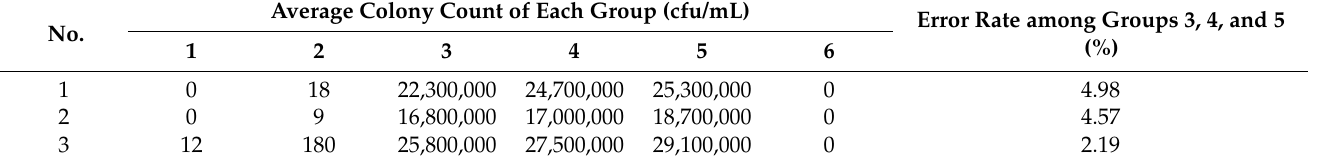
Table 2. Neutralizer test